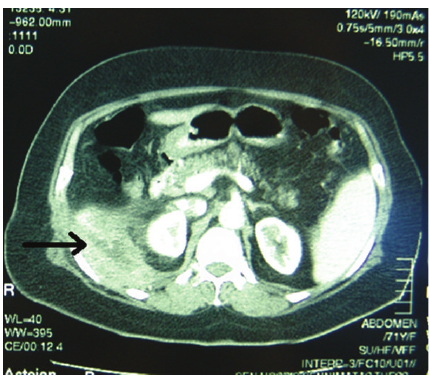
Figure 2: CT scan showing a retroperitoneal abscess (arrow) due to retained